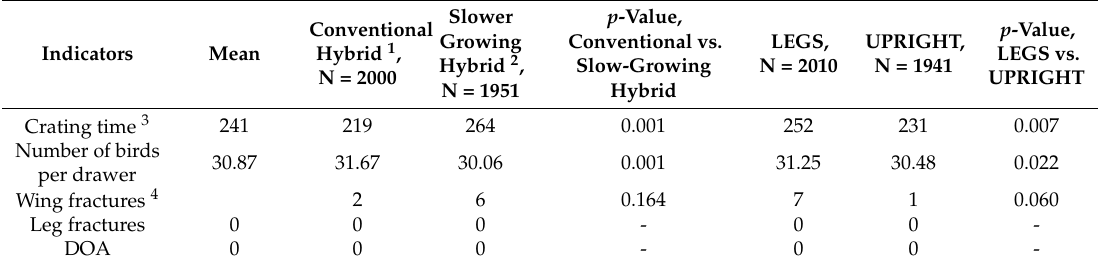
Table 1. Outcome measures of upright and leg catching methods, trialled in one conventional and one slow-growing flock of